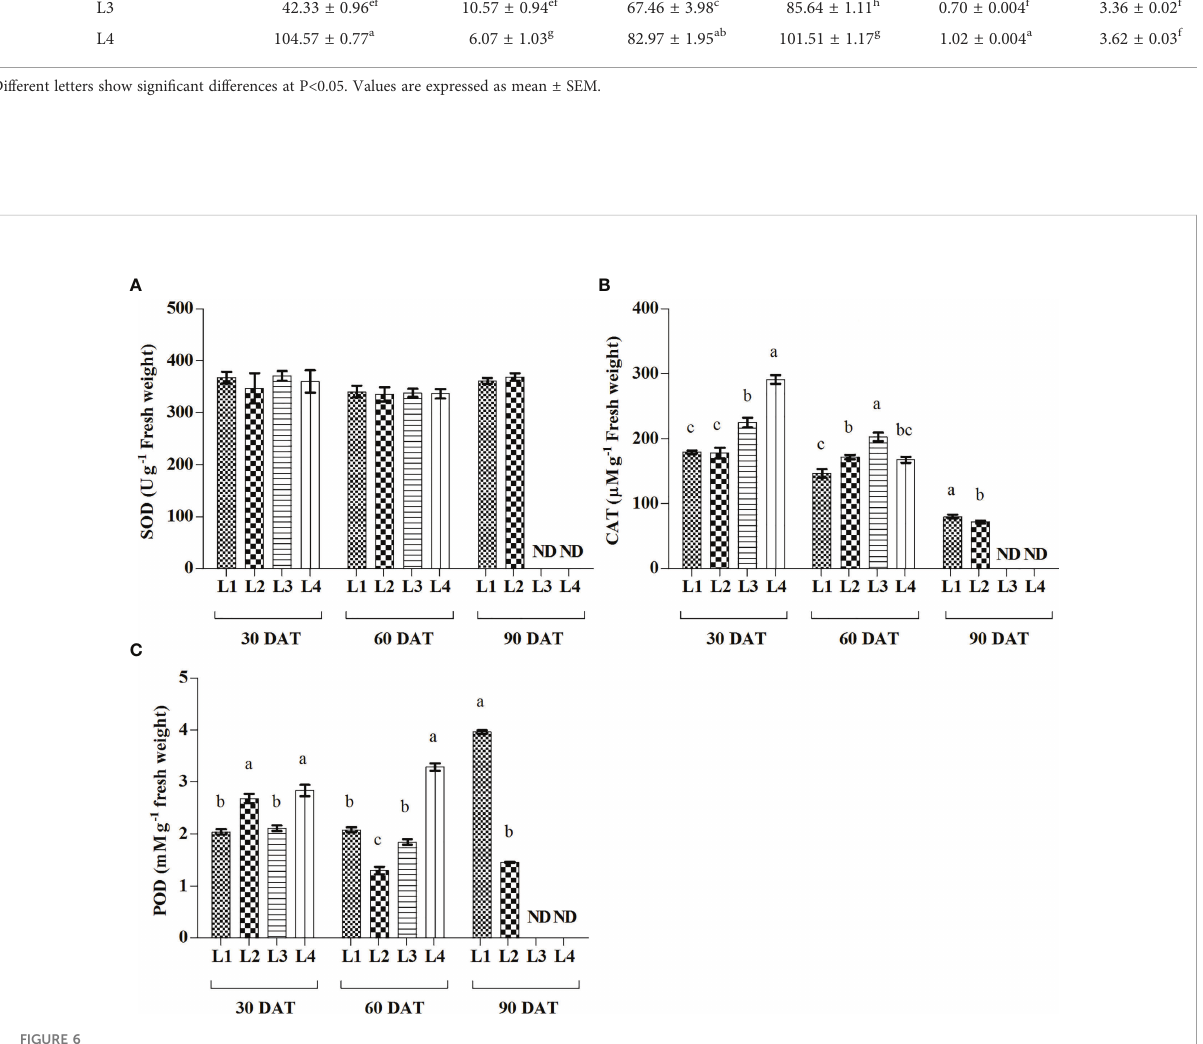
Different letters show signi fi cant differences at P<0.05. Values are expressed as mean ±